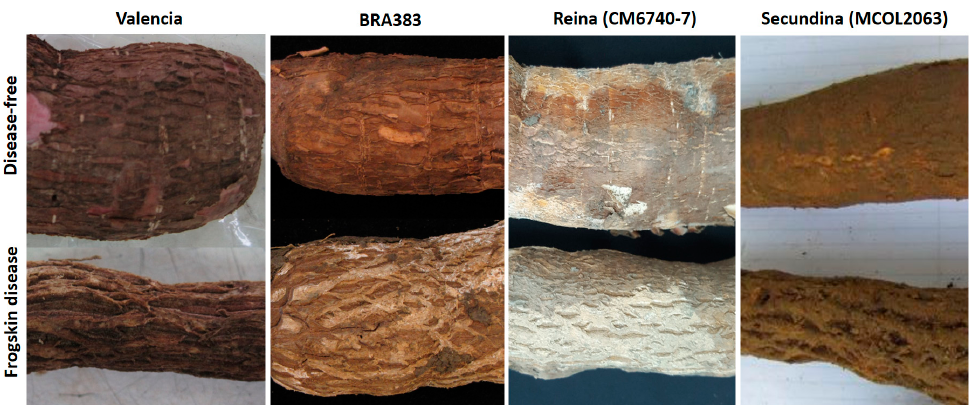
Figure 1. Root symptoms of CFSD as observed in four different field-infected cassava genotypes: Valencia, BRA383, Reina (CM6740-7), and Secundina (MCOL2063). Top pictures correspond to roots showing no symptoms of the disease. Bottom pictures show the characteristic root symptoms of CFSD.